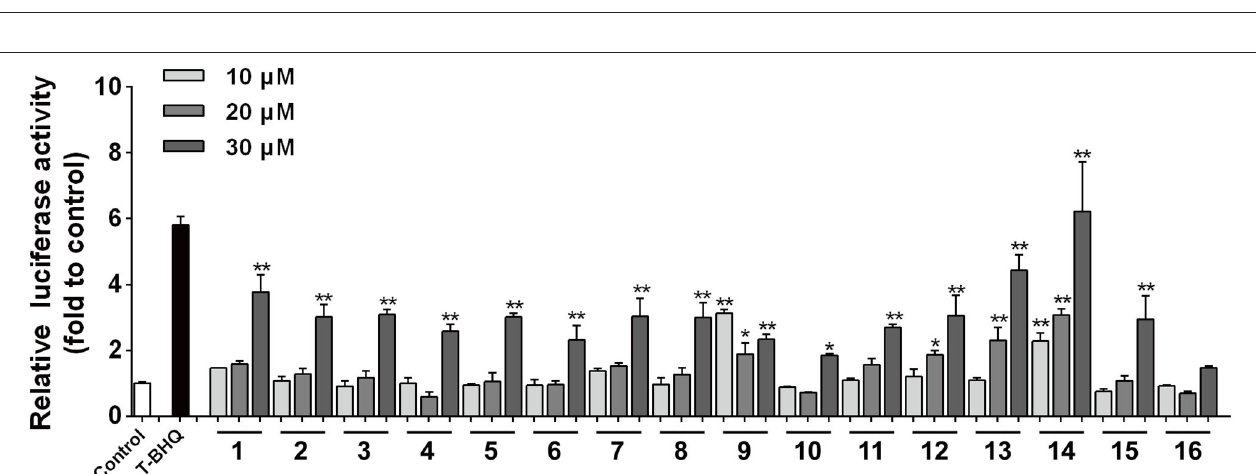
FIGURE 5 | Experimental and calculated ECD spectra of new compounds 1 , 2 , 6 , and 7 .